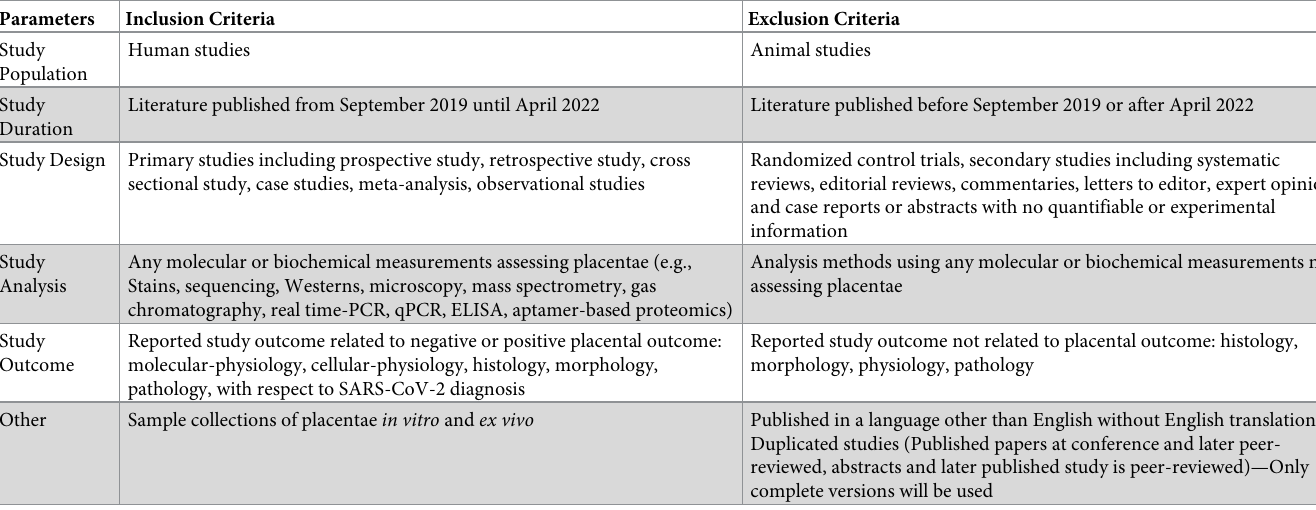
Table 1. Inclusion and exclusion criteria for data